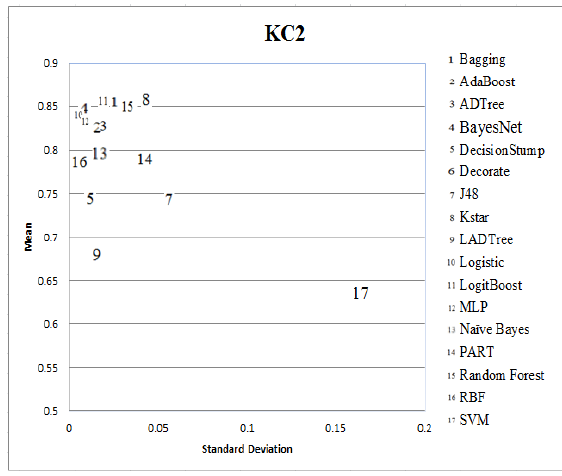
Figure 10. AUC value mean with 4 scenarios and deviation from mean value in KC2 dataset classification.